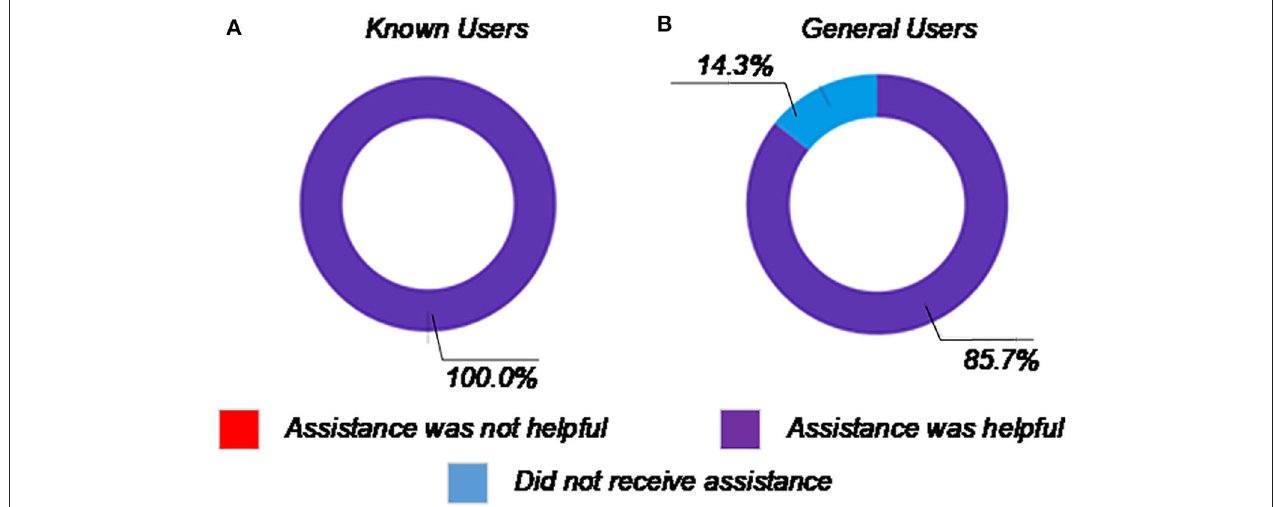
FIGURE 6 | Satisfaction with proposal writing feedback by user group. (A) is the known users, and (B) is the general users.